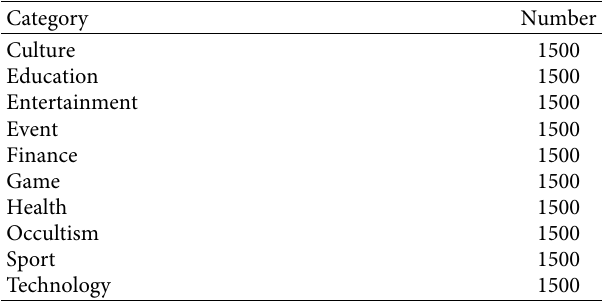
Table 1: The number of Chinese balanced corpora.